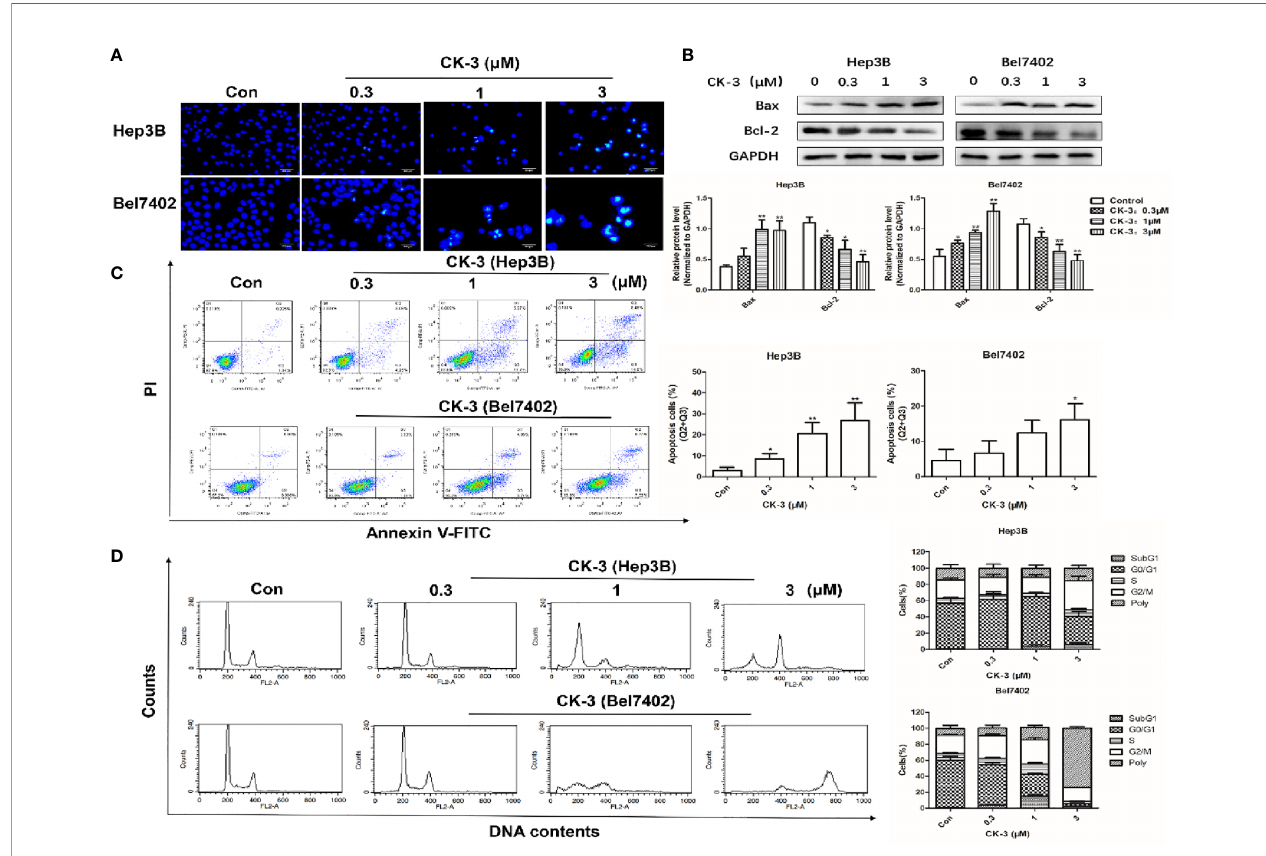
FIGURE 5 | Effects of CK-3 on Hep3B and Bel7402 cell apoptosis and reproduction. (A) Morphology of the cell nuclei changes following incubation with CK-3 for 48 h, as visualized with Hoechst 33342. Scale bar =200 m m. (B) The level of Bax and Bcl-2 in cells treated with CK-3 at various concentrations for 48 h was evaluated with western blotting. All blotted proteins were normalized to GAPDH. (C) Annexin V-FITC/PI double-staining of cells after 48 h of CK-3 treatment. Bar graphs show the quanti fi cation of the apoptotic cells. (D) DNA analysis of cells after CK-3 treatment was performed using fl ow cytometry. The percentage of cells in each phase of the cell cycle is shown in the histogram. Data are presented as mean ± SD of three independent experiments (n = 3). * p < 0.05, ** p < 0.01, compared with the control